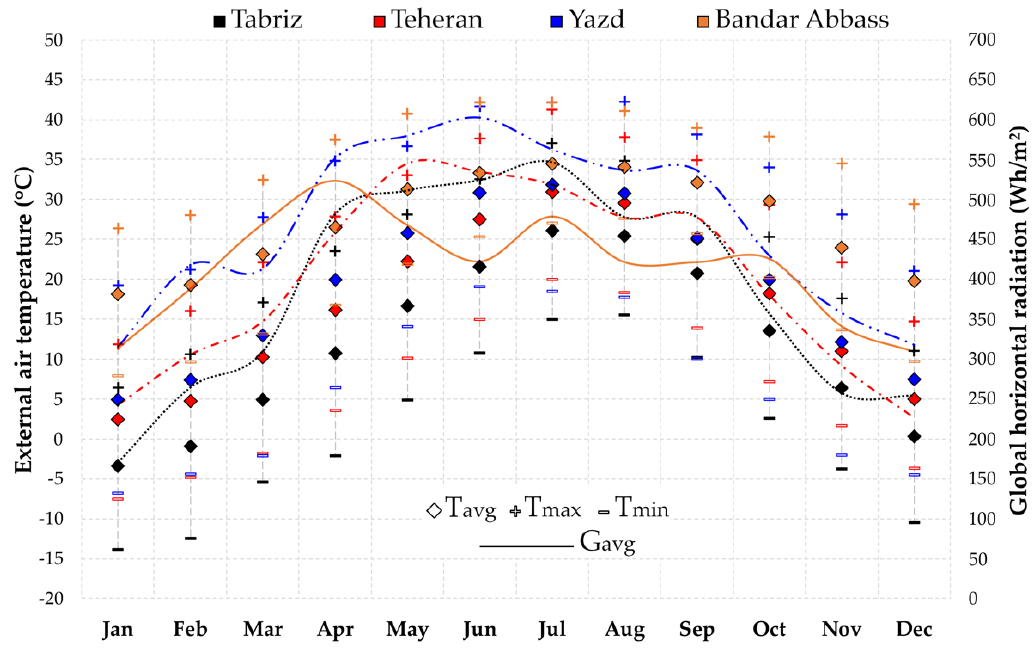
Figure 3. Monthly trends of T min /T avg /T max and G avg for each city.